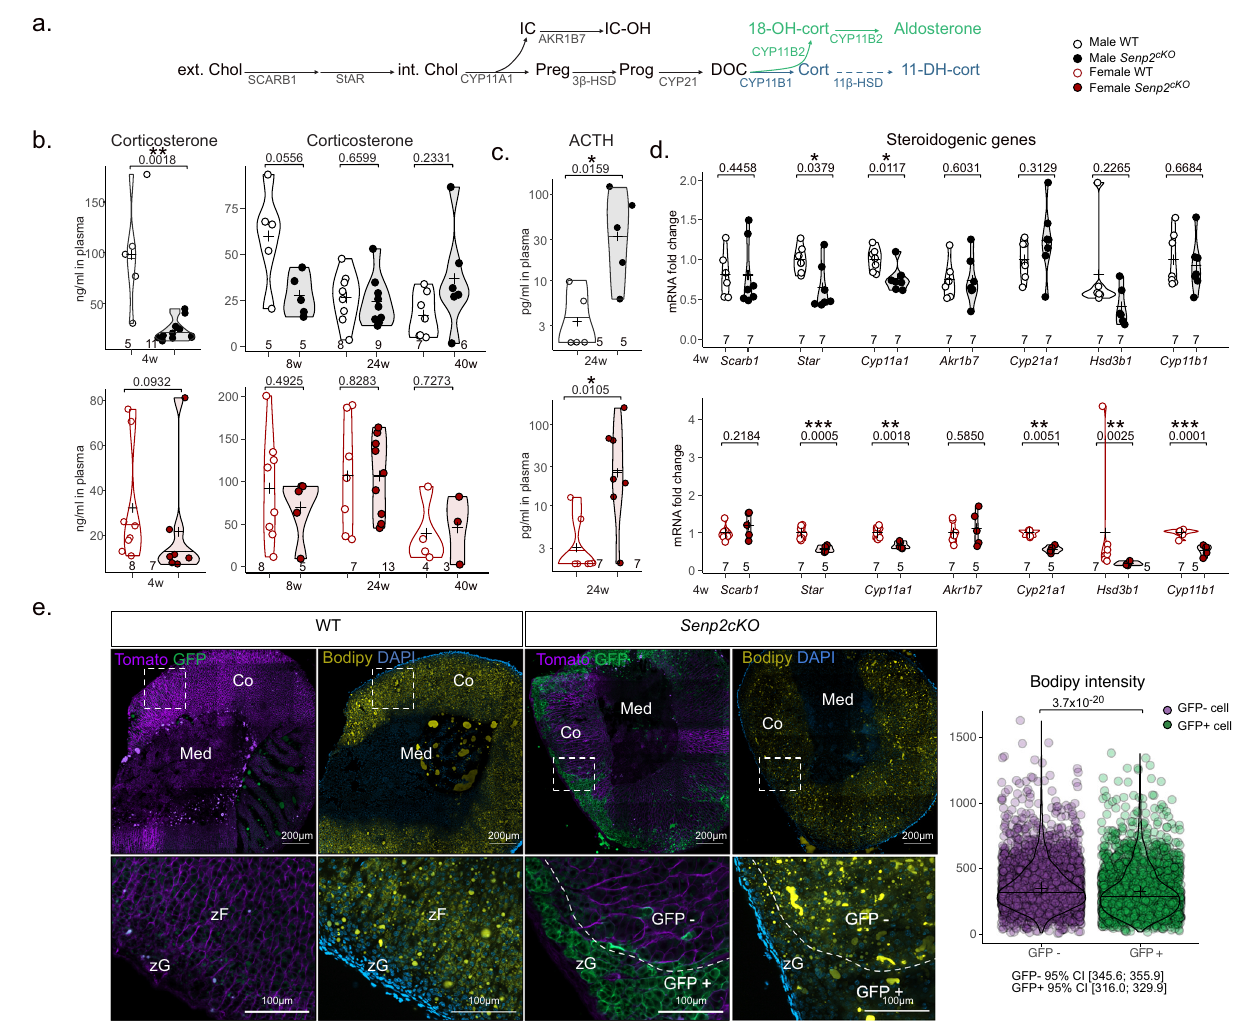
Fig. 2 | Senp2 invalidation induces isolated glucocorticoid insuf fi ciency. a Schematic representation of gluco- (blue) and mineralo- (green) corticoids synthesis: ext.Chol/int.Chol extra/intracellular cholesterol, Preg pregnenolone, Prog progesterone, DOC 11-deoxy-corticosterone, cort corticosterone, 18-OH-cort 18hydroxycorticosterone, including detoxication of cholesterol side-chain clivage IC (Isocaproaldehyde) into IC-OH (isocapryl alcohol) and inactivation of corticos- terone into 11-DH-cort (11-dehydrocorticosterone). b Plasmatic concentration of corticosterone in WT and Senp2 cKO at 4 (determined by ELISA), 8, 24 and 40 weeks ofage(determinedbyLC – MS/MS). P valuesweredeterminedbytwo-sided t